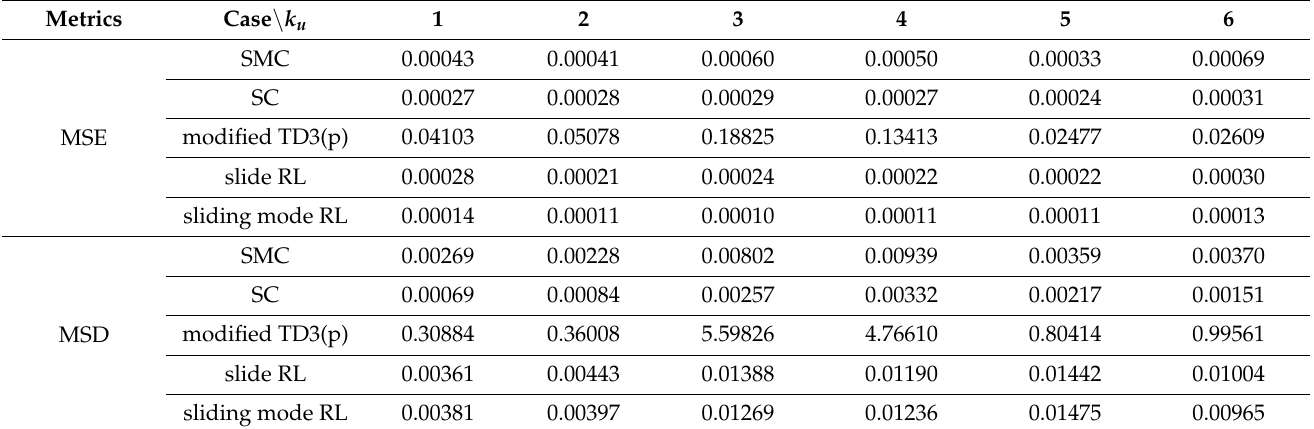
Table 3. Performance of the sliding mode RL for the various system